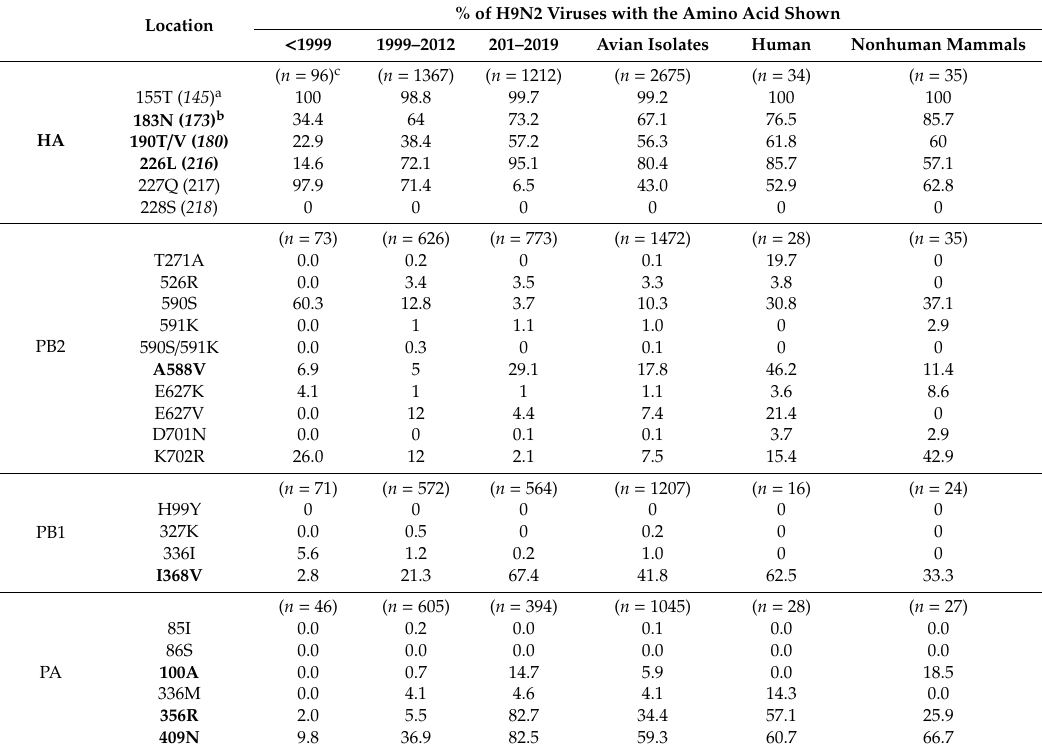
Table 1. Prevalence of mammalian adaptation markers among H9N2 influenza viruses. % of H9N2 Viruses with the Amino Acid Location